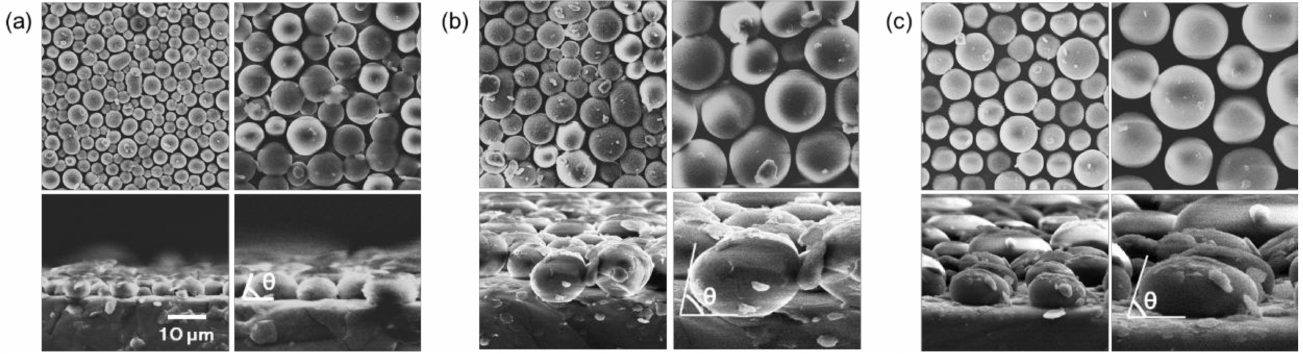
Figure 2. The scanning electron microscopy (SEM) images of the micro-sphere PDMS film: ( a ) 22.5 mg/mL concentration; ( b ) 45 mg/mL concentration; ( c ) 67.5 mg/mL concentration; ( top ) top- view, ( bottom ) cross-sectional view and magnified sphere shape for determination; scale bar shows 10 µ